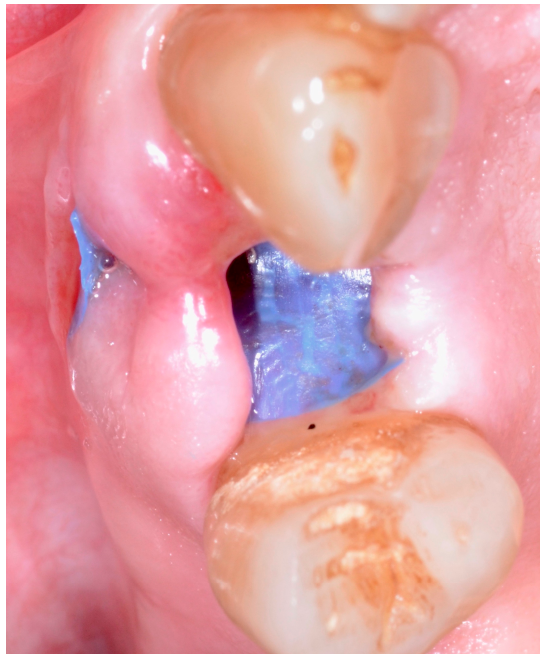
Figure 5. Clinical situation four weeks after membrane placement showing no signs of bacterial inflammation.